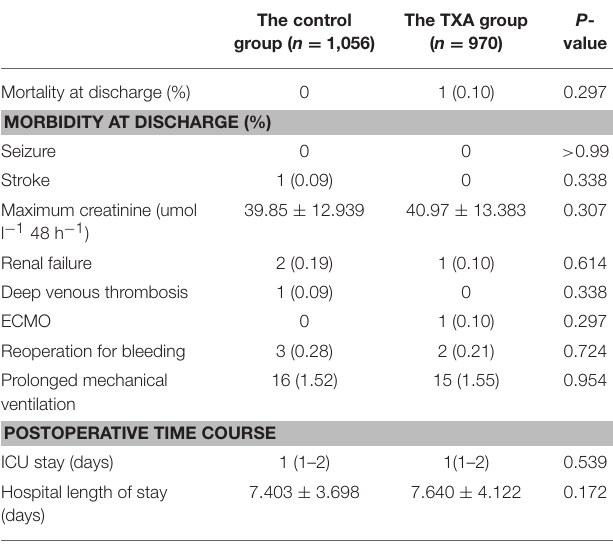
TABLE 4 | Postoperative